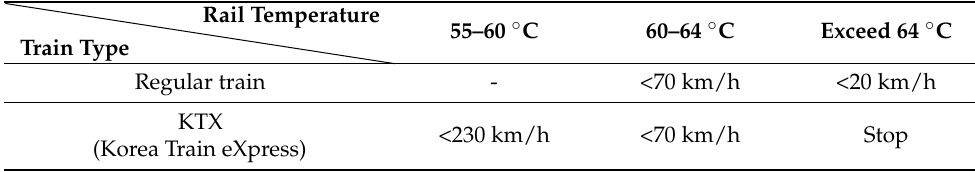
Table A5. Train driving rules according to rail temperature in KORSMA.